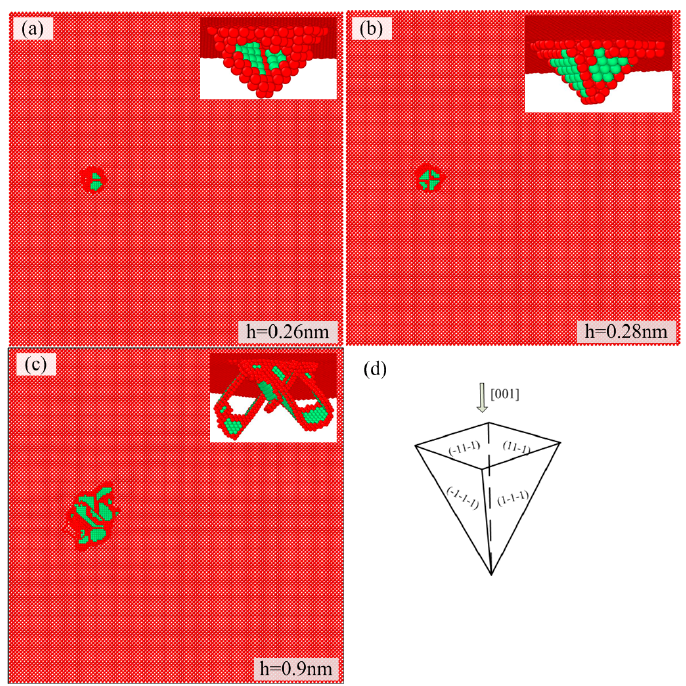
Figure 8. Atom configuration during indentation process without residual stress: ( a – d ) schematic of four inclined {111}-type slip planes for (100) indentation. The green color shows stacking faults.